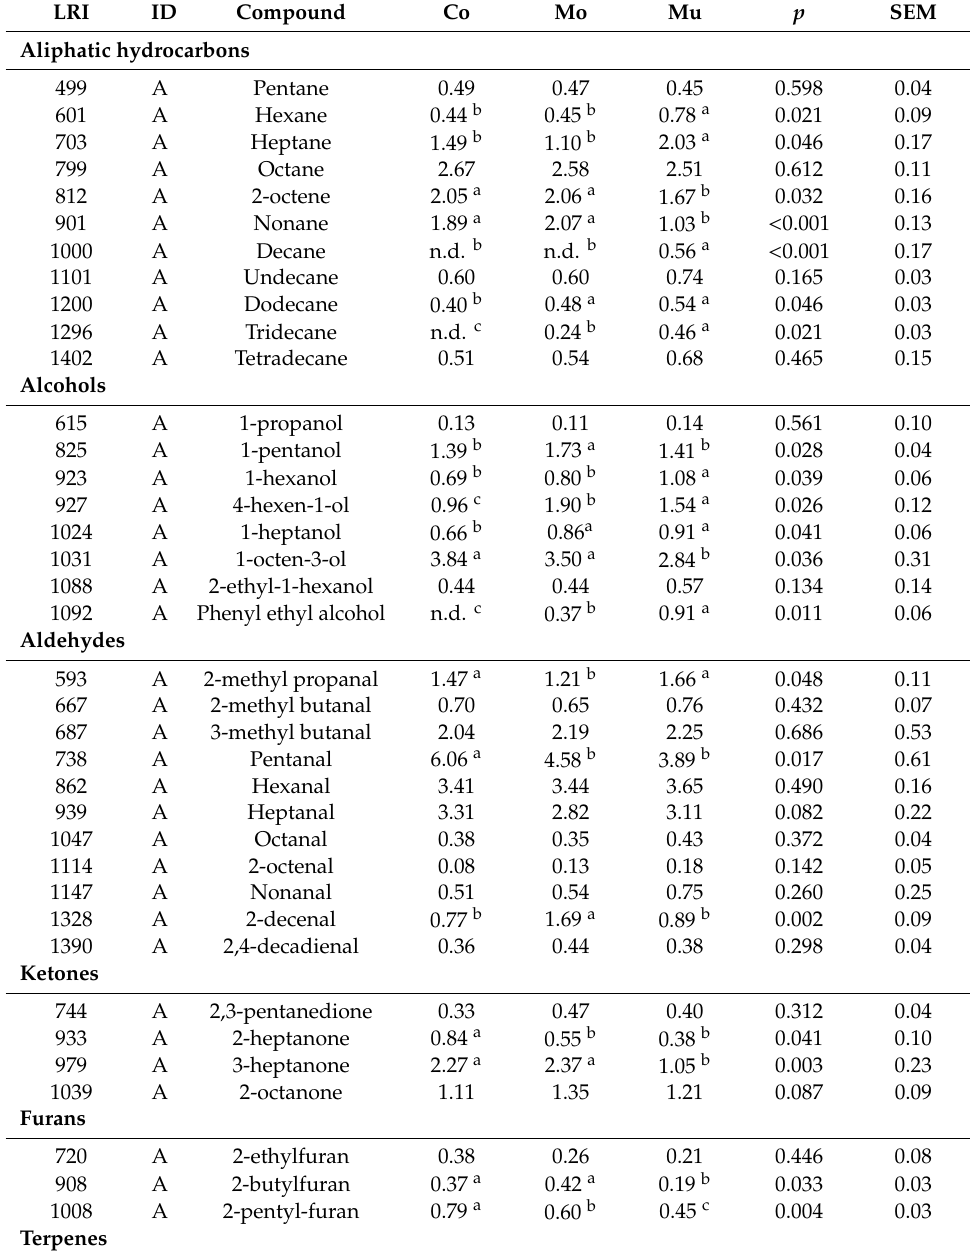
Table 3. Volatile compounds (arbitrary area units × 10 6 ) on cooked sausages (C-SAU) as a ff ected by enrichment with fish oil microcapsules ( p )